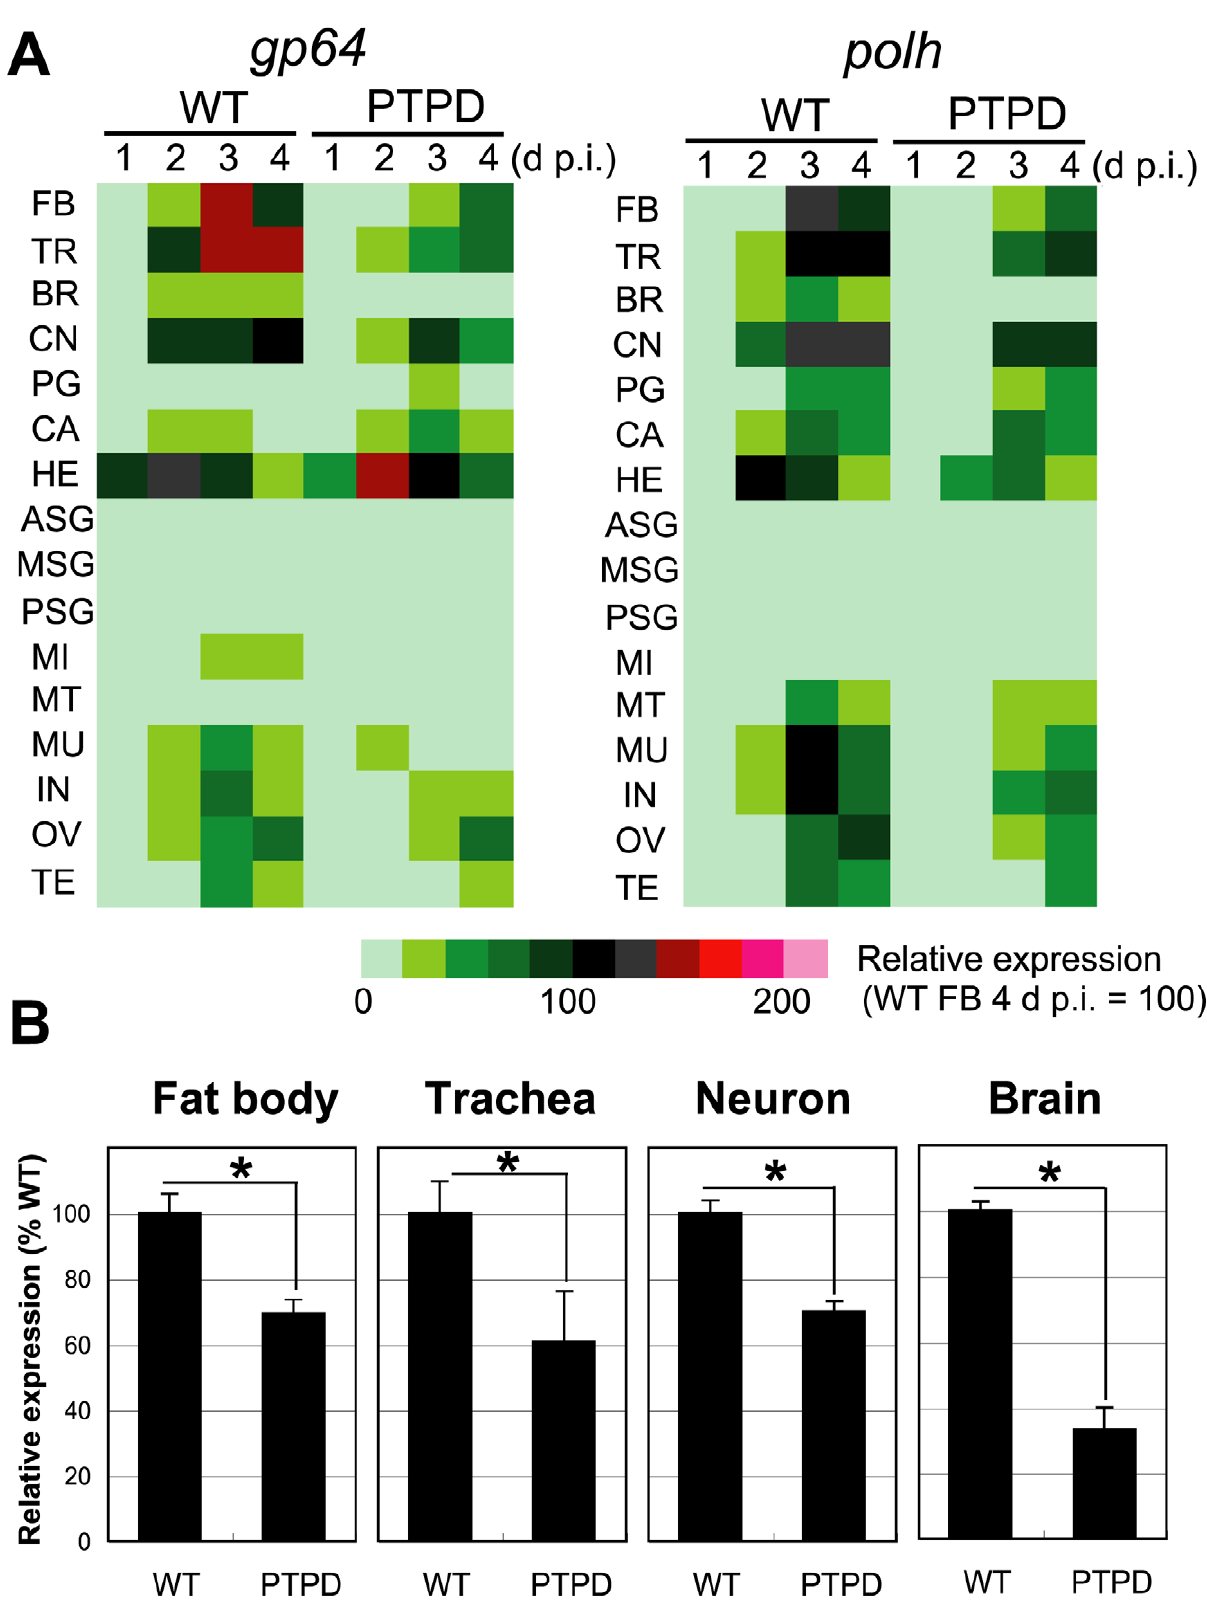
Figure 5. Reduced expression of viral genes in tissues of larvae infected with a ptp -disrupted virus. (A) Heatmaps of viral gene expression in 16 tissues of 5 th instar B. mori infected with BmNPV (WT) or BmPTPD (PTPD). The tissues were dissected from virus-infected larvae at 1, 2, 3, and 4 d p.i., and the expression of the early/late and very late genes gp64 and polh , respectively, were quantified by qRT-PCR. Tissues from 5 to